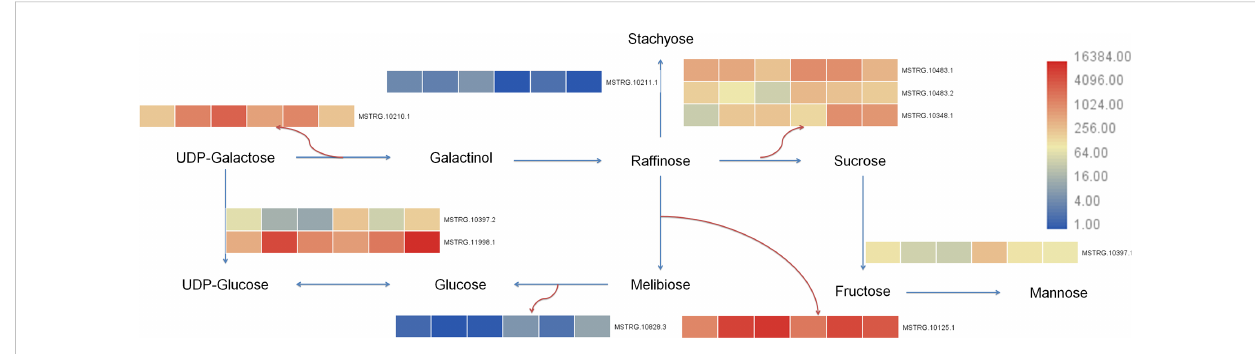
FIGURE 9 Galactose metabolism pathway in buckwheat leaves under Cd stress. The sample number in the order from left to right in the heat map: DK9-0, DK19-1, DK19-2, K33-0, K33-1 and